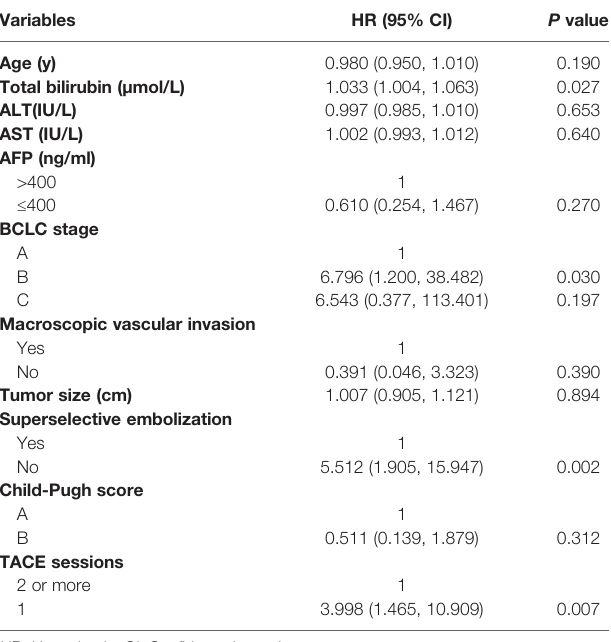
TABLE 3 | Multivariate analysis of prognostic factors for overall survival (OS). Variables